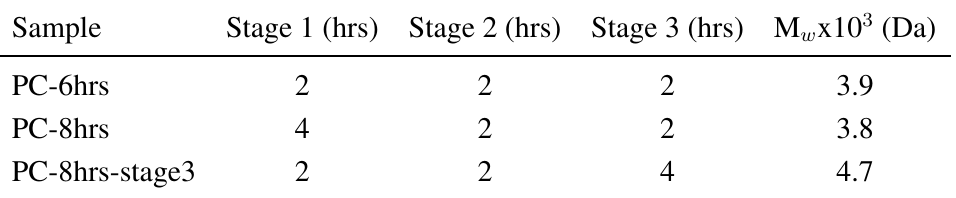
Table 6. GPC results for the three-stage PC synthesis at 120 ◦ C